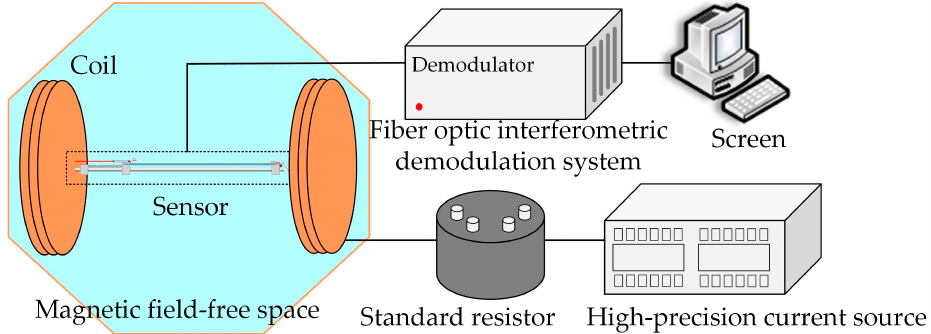
Figure 4. The experimental test diagram of optical fiber magnetic field sensors.